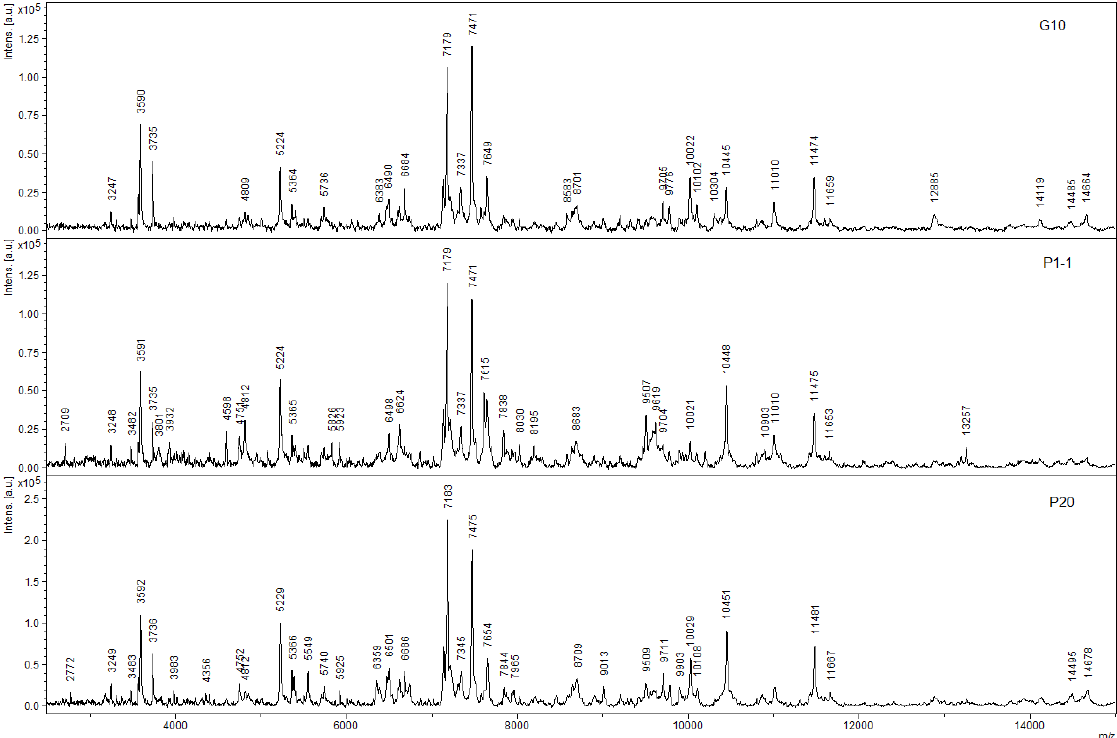
Figure 4. MALDI-ToF spectra of partially purified preparations of ClcF R. wratislaviensis G10, P1, P20 (from top to bottom ).